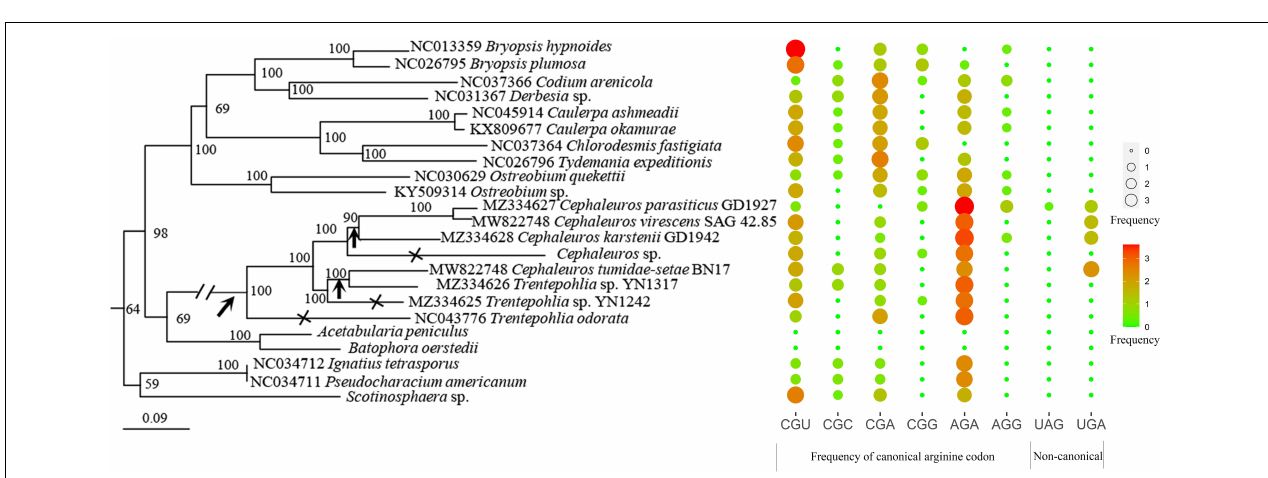
FIGURE 3 | Sequence logo of the position weight matrix reporting the relative amino acid frequencies in the alignment for each abnormal UGA/UGA position in Trentepohliales.